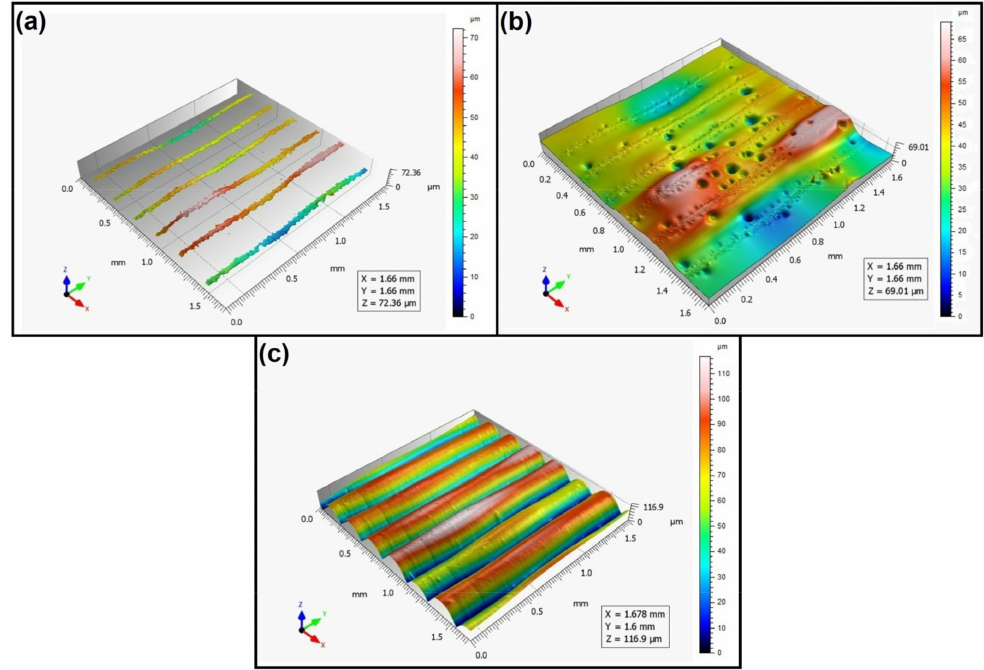
Figure 6. Surface topography of the element 3D printed using FDM technology (Pd = 0 ◦ ). ( a ) Talysurf CCI—without filling non-measured points, ( b ) Talysurf CCI—after filling non-measured points, ( c ) Talysurf PGI 1230.